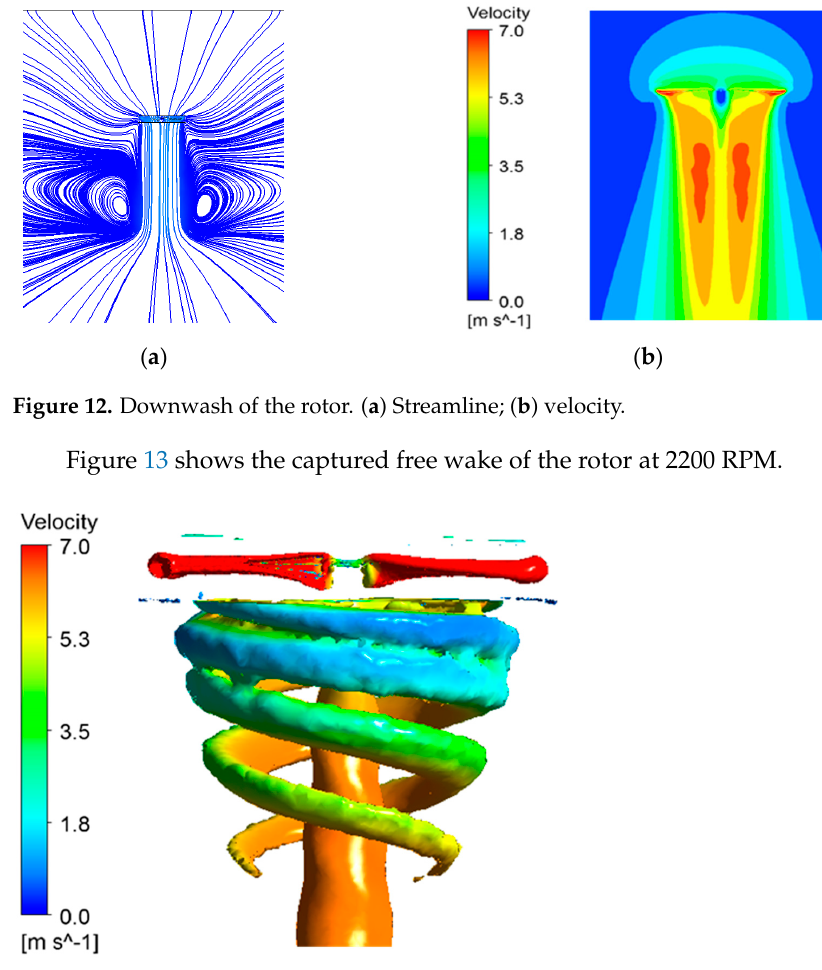
Figure 13. Free wake of the rotor.